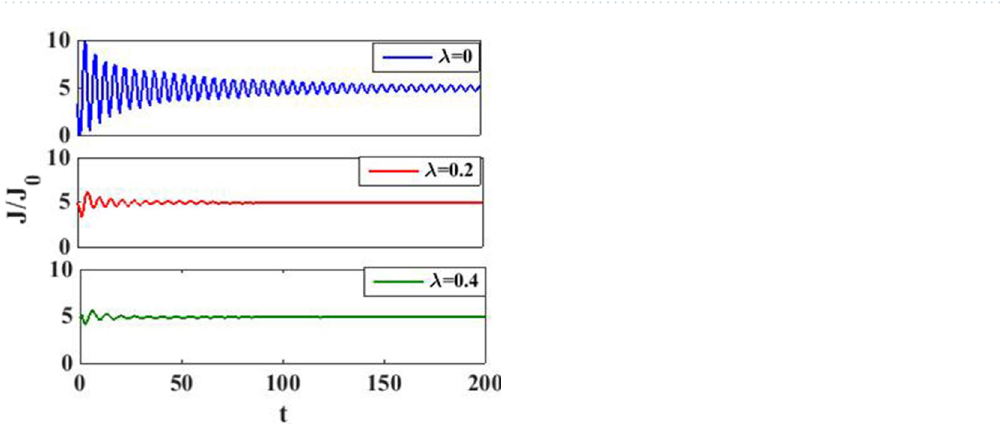
Figure 11. J / J 0 versus t for various values of (cid:31) at eV g = 0.6